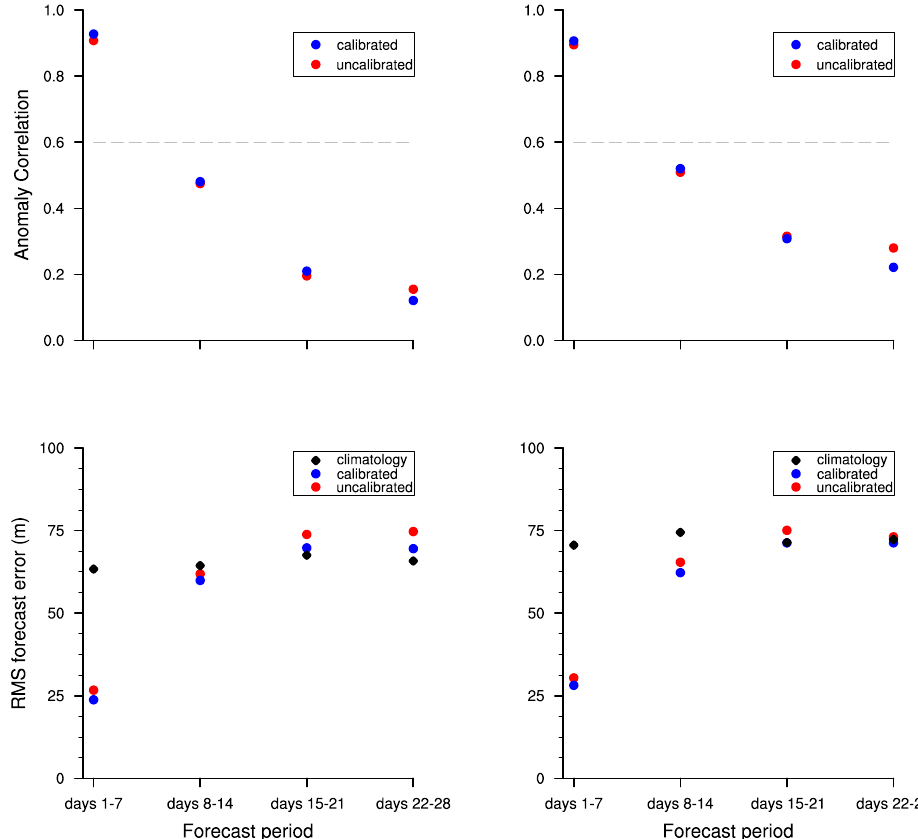
Figure 3. Anomaly correlation (top panels) and root mean squared (RMS) error (m, bottom panels) computed from 13 monthly forecast anomalies of 500-hPa geopotential height over the Northern (left panels) and Southern (right panels) Hemisphere extratropics. Blue markers are obtained from calibrated anomalies, red markers from uncalibrated (raw) anomalies. The black markers in the bottom panels represent the RMS computed from 1989–2009 ERA-Interim